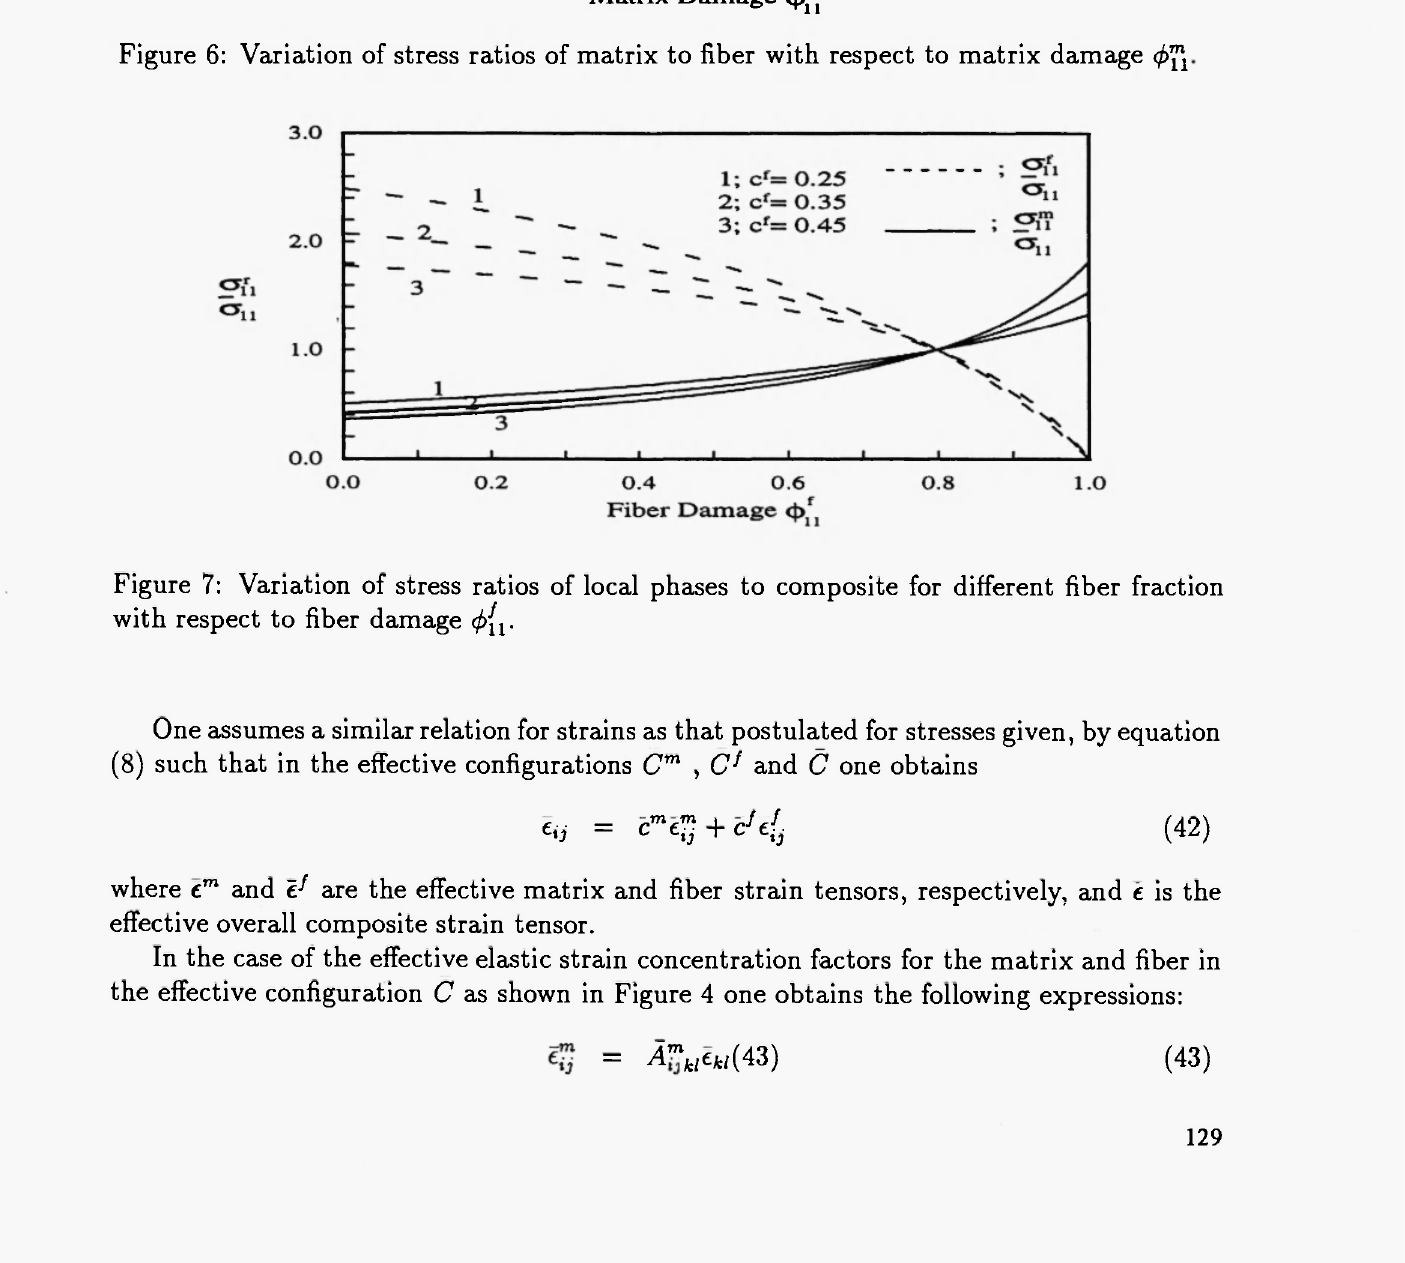
Figure 6: Variation of stress ratios of matrix to fiber with respect to matrix damage φft